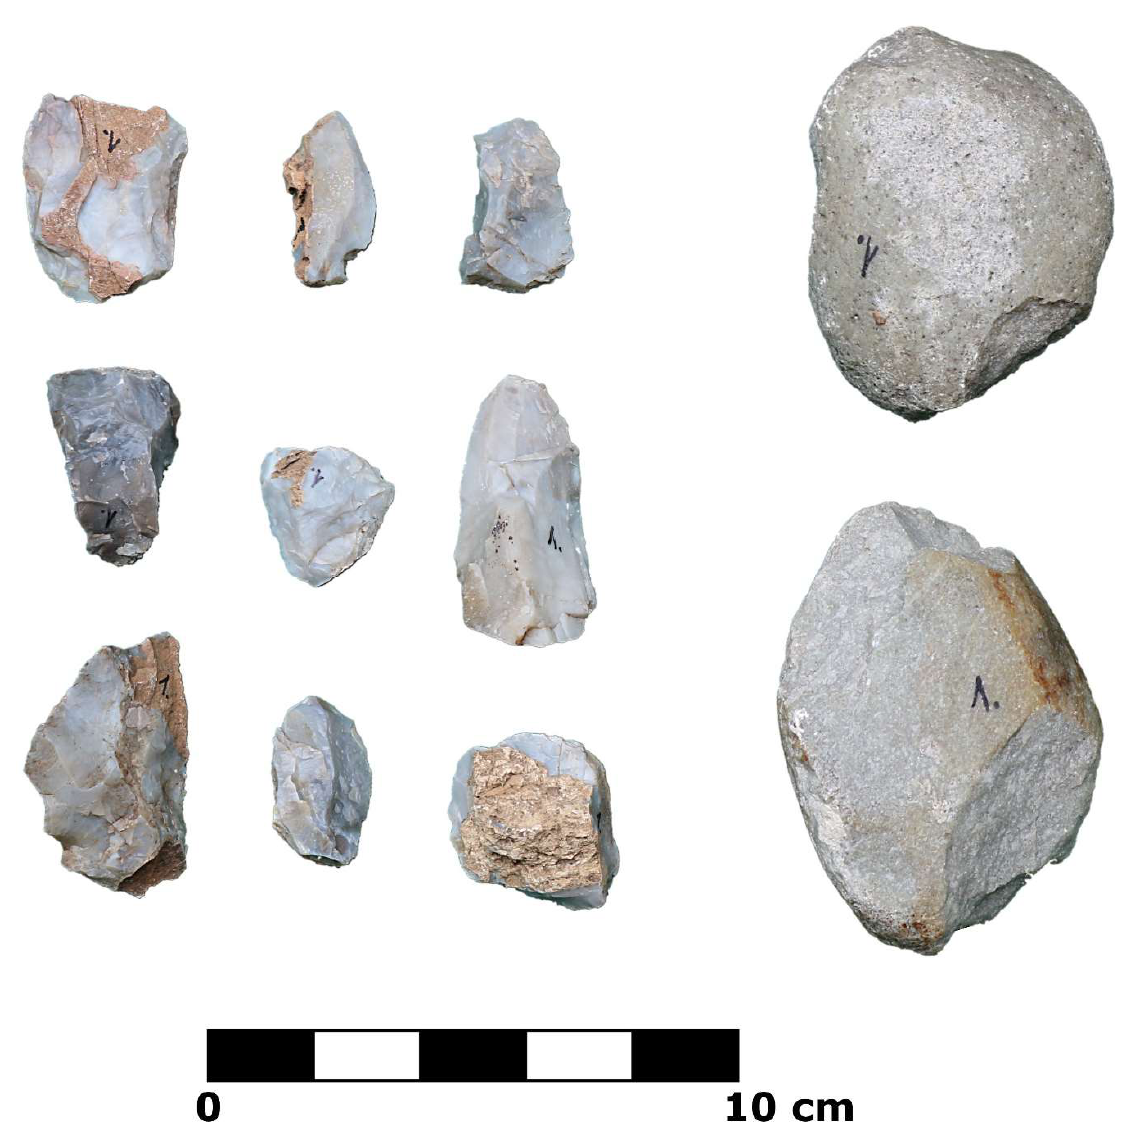
Figure 10. Knapped flakes and fragments of hammerstone from Farkas-völgy 1. (Photo and CAD by N. Faragó) Fig. 10. Éclats taillés et fragments de percuteur provenant de Farkas-völgy 1. (Cliché et DAO: N.